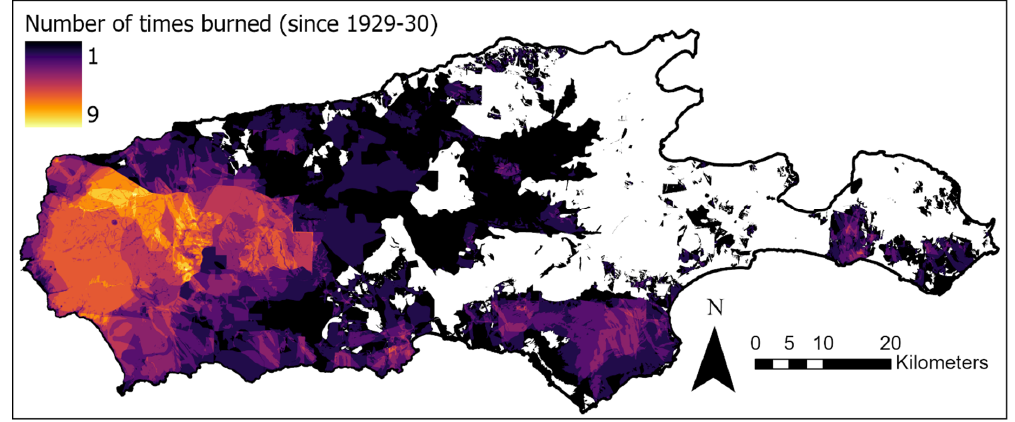
Figure 5. Number of times burned since 1930. Based on the size of fire history polygons [45] to be consistent across the entire record. Polygons from 1950 and onwards were used in the creation of fire history variables (BLX, SLB).